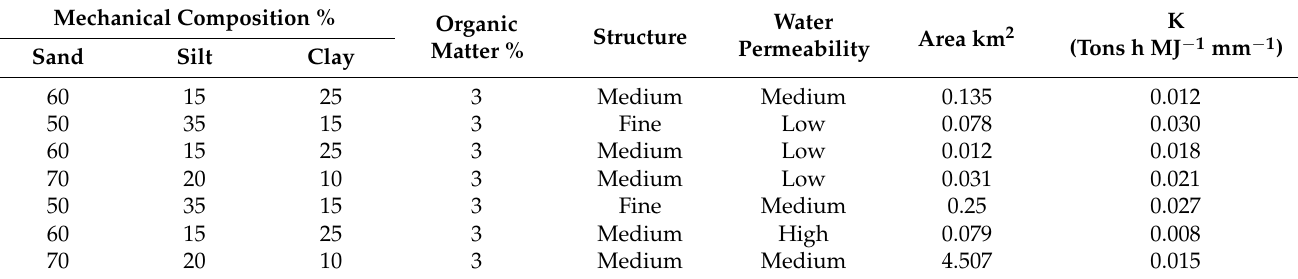
Table 3. K factor values and the main soil characteristics of the study